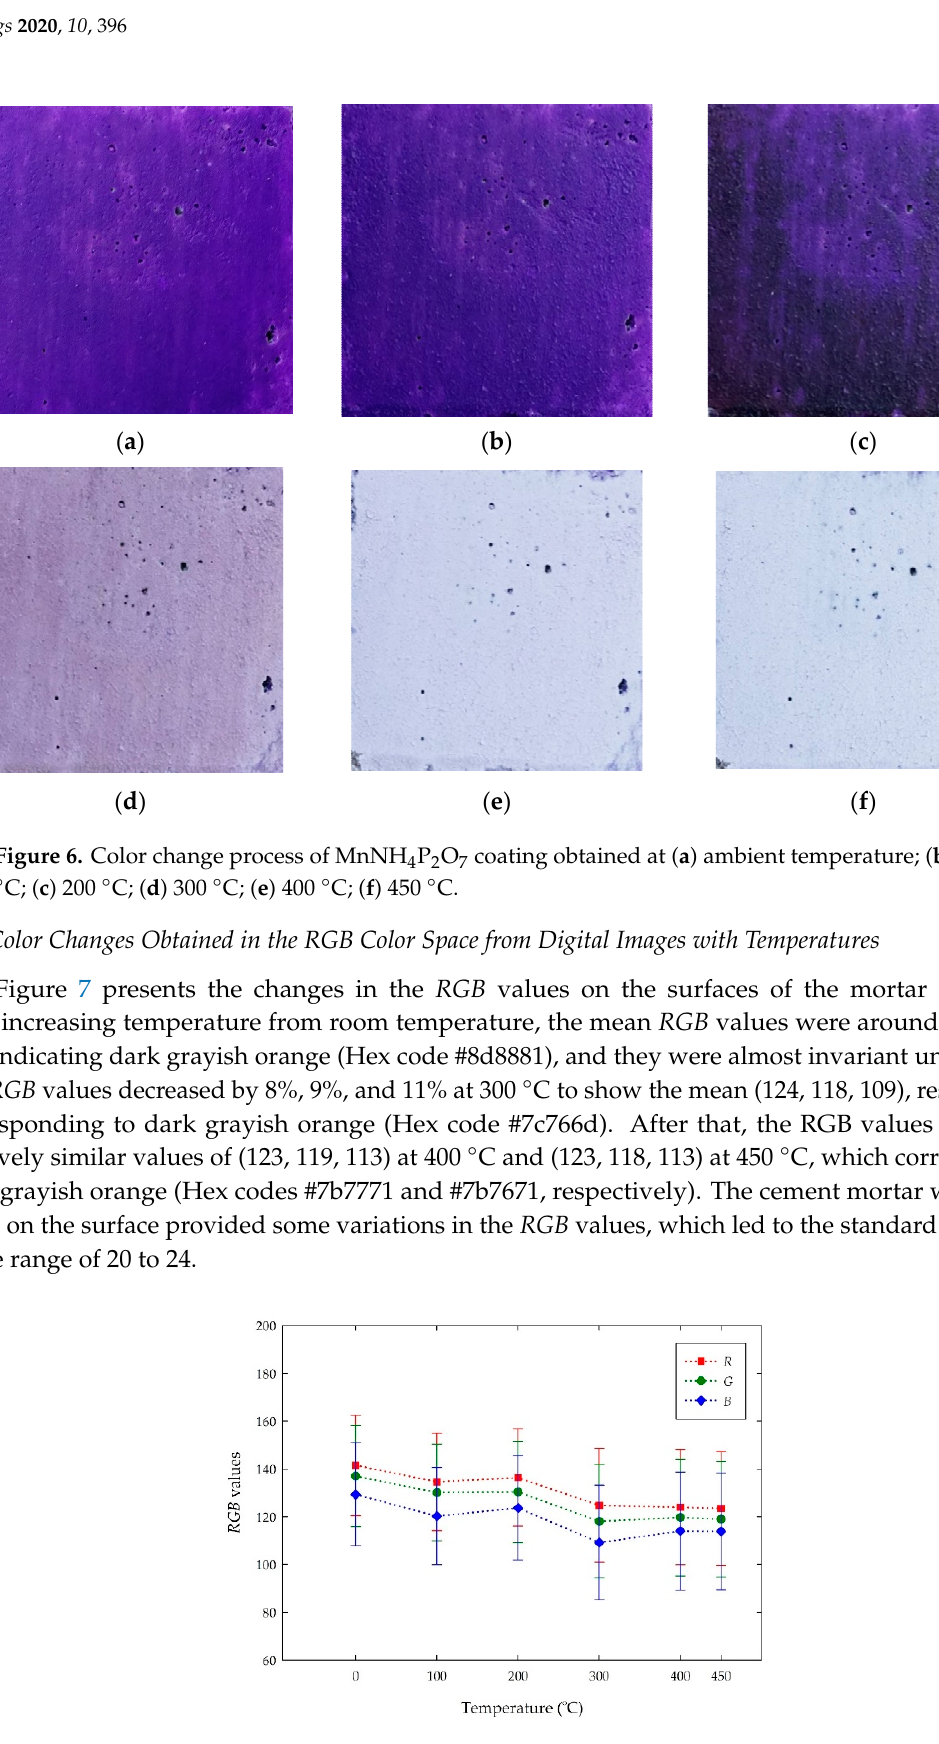
Figure 7. Color changes and their standard deviations of the mortar surfaces obtained in RGB values.